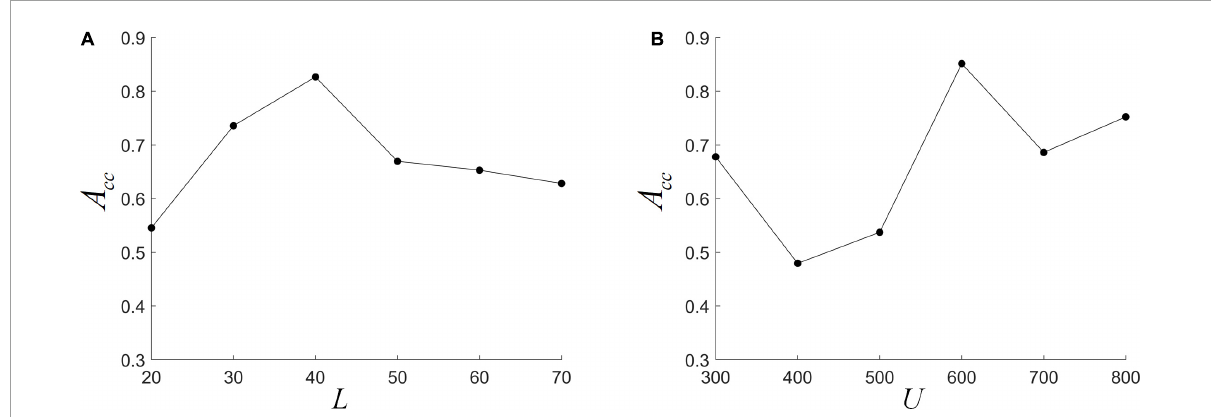
FIGURE5 The effect of different parameters on classification performance. (A) The different window length L ; (B) the different cluster number U .